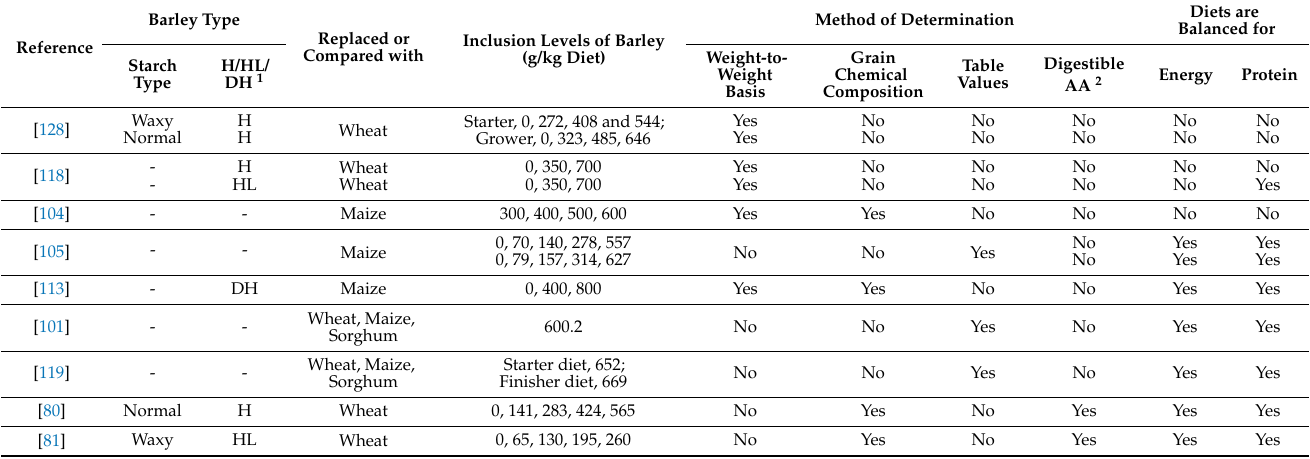
Table 9. Comparison of studies evaluating barley inclusion in broiler